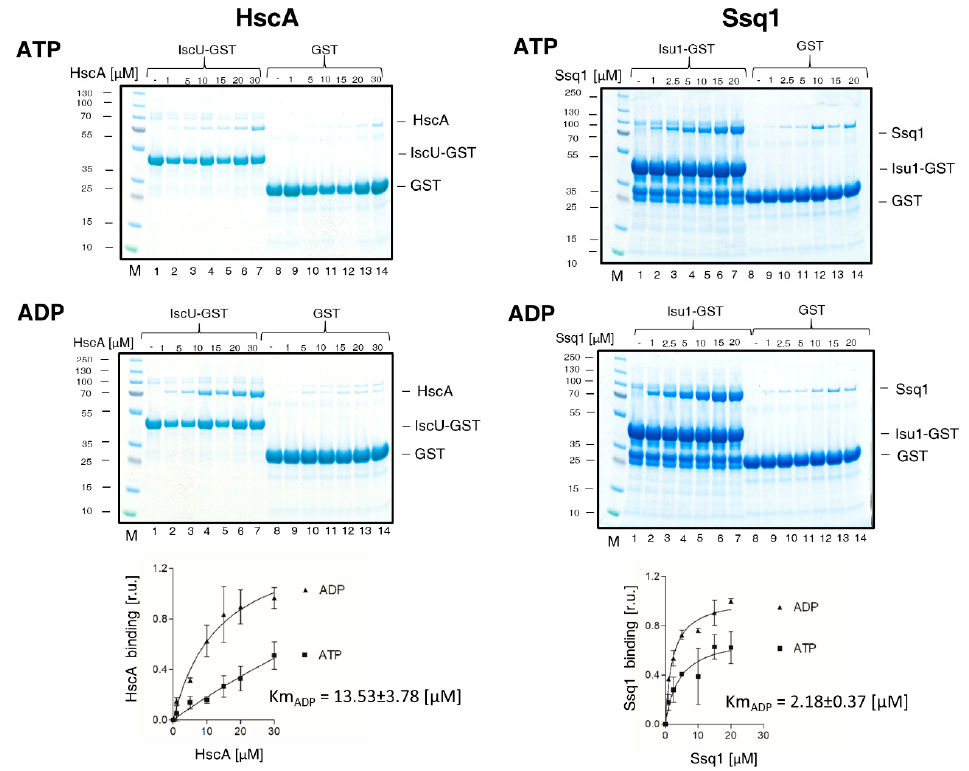
Figure 3. A ffi nity of HscA and Ssq1 for protein substrate (IscU / Isu1) in the presence of ATP or ADP. ( left ) IscU-GST (15 µ M) or GST (15 µ M) were incubated in the presence of ATP or ADP (4 mM) with increasing concentrations of HscA, as indicated. Glutathione resin was added to pull-down GST and associated proteins, which were then separated by sodium dodecyl sulfate-polyacrylamide gel electrophoresis (SDS-PAGE) and stained with Coomassie Blue. “M” indicates lanes having molecular weight markers; controls of loading are shown in Supplementary Figure S4. Bound HscA was quantitated by densitometry. Values were plotted as relative units (r.u.) with maximal signal for HscA set as 1. Curves represent best fit of the data to the Michaelis-Menten hyperbolic equation. The Km value obtained in the presence of ADP (Km ADP ) is listed. Error bars represent SD for three independent measurements. ( right ) Isu1-GST or GST (30 µ M) were incubated in the presence of ATP or ADP (4 mM) with increasing concentrations of Ssq1. Procedure was as described above for HscA / IscU.